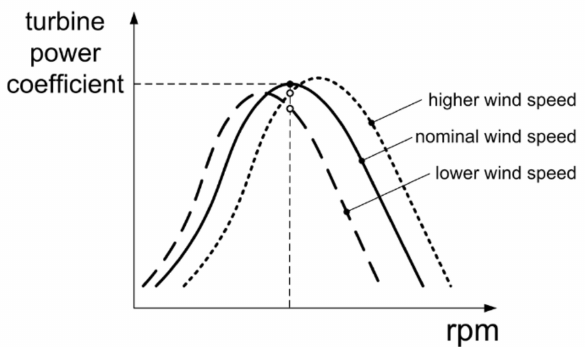
Figure 3. Schematic representation of the variation of turbine power coe ffi cient due to a local variation of the incoming wind velocity at a fixed revolution